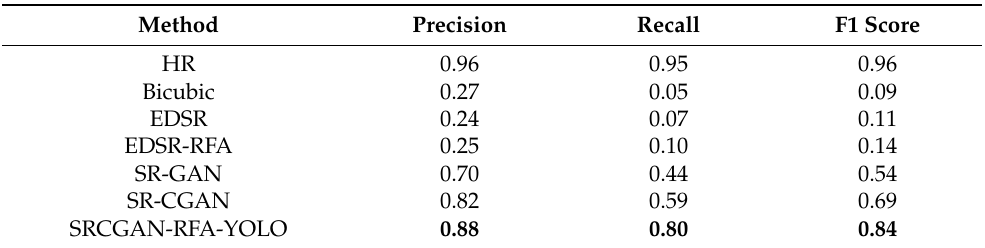
Table 9. Detection performance on an independent dataset with a GSD of 80 cm/pixel (IoU of 0.10). (Bold = best